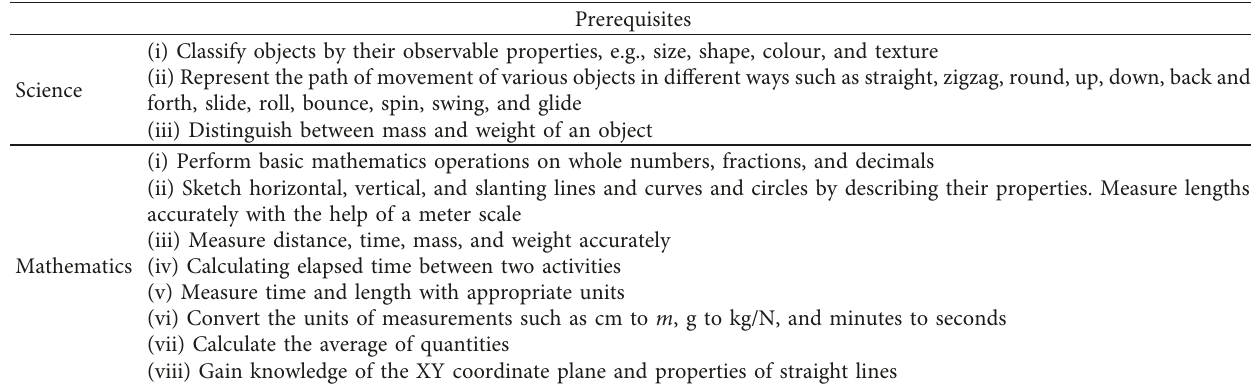
Table 1: List of